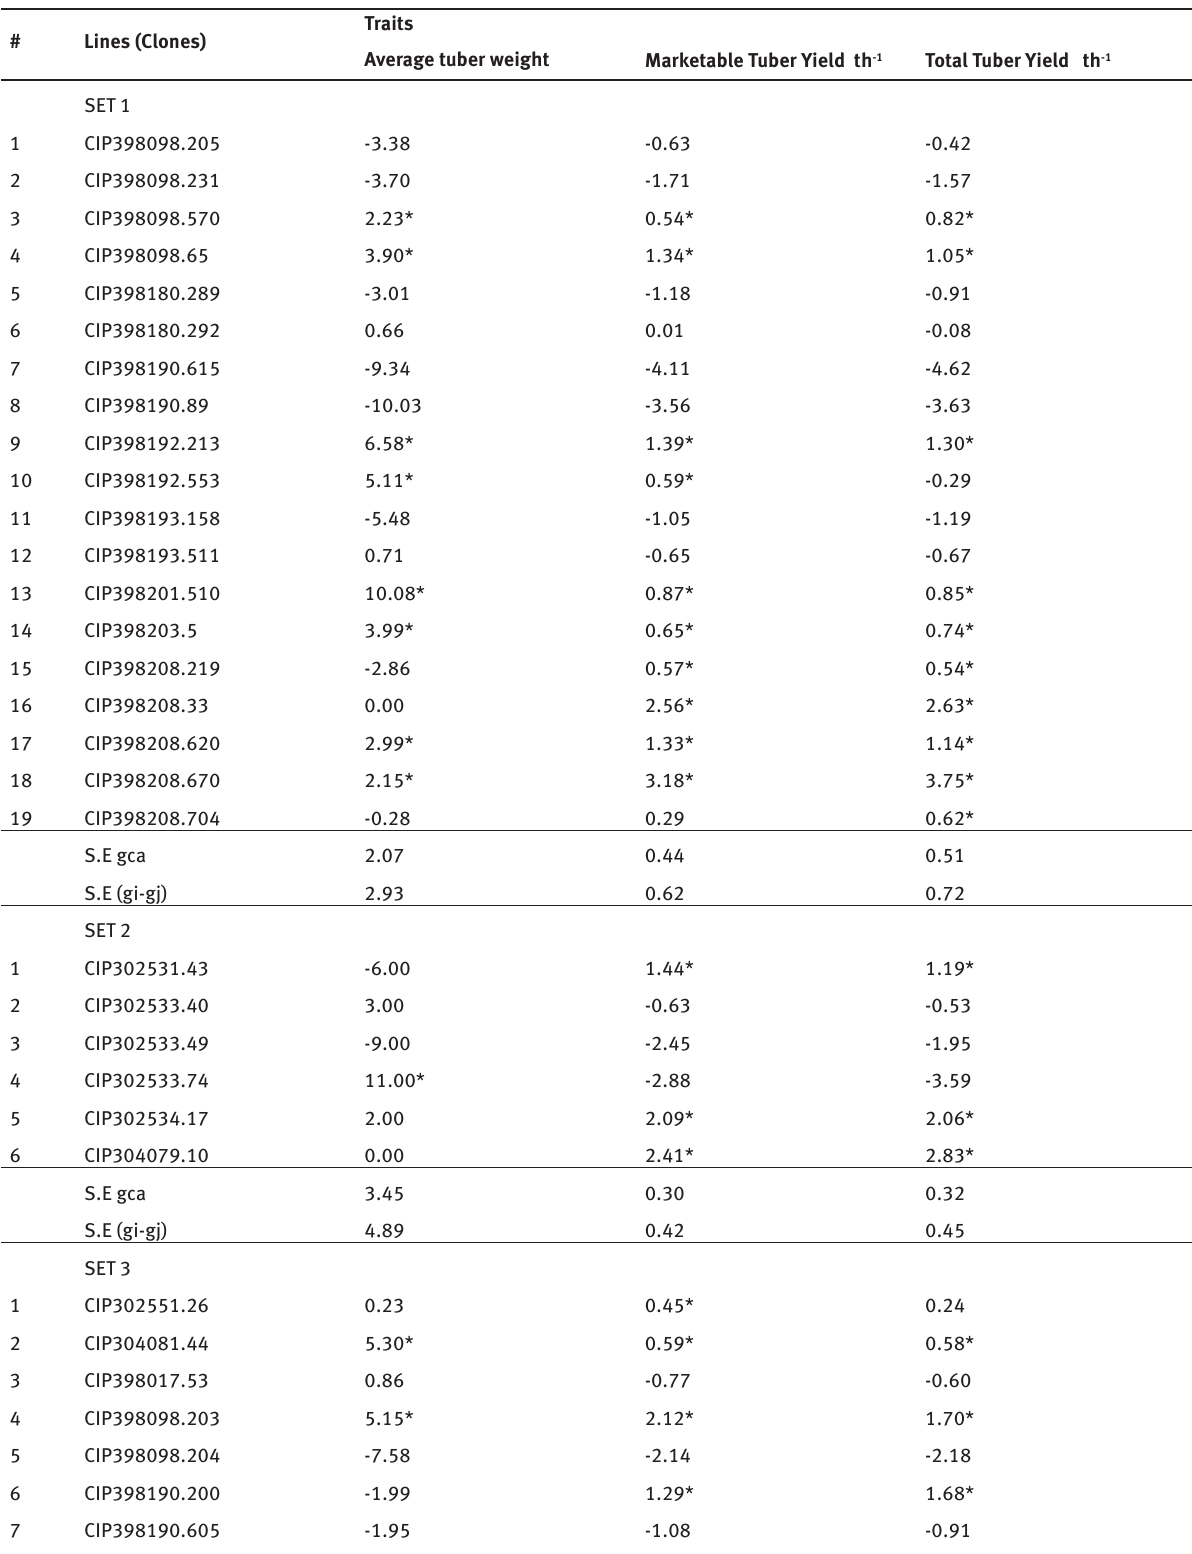
Table 6: Estimates of General Combining Ability (GCA) effects for lines (clones), pooled over locations for average tuber weight, marketable and total tuber yiel in three sets of clones from LBHT